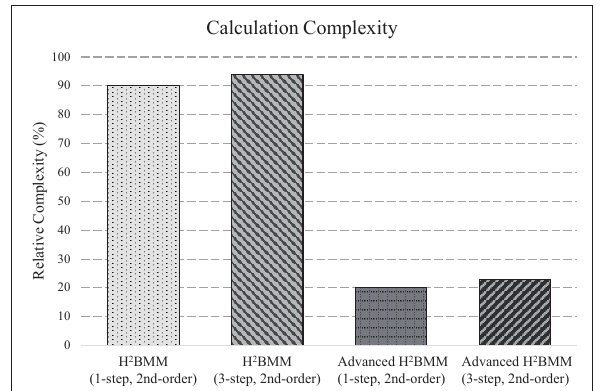
Figure 14. C omputation Complexity of Advanced H 2 BMM and H 2 BMM